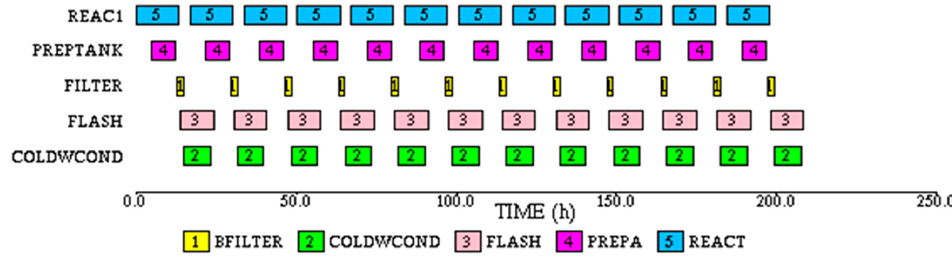
Figure 16. Gantt chart for the case with modified utility usage.